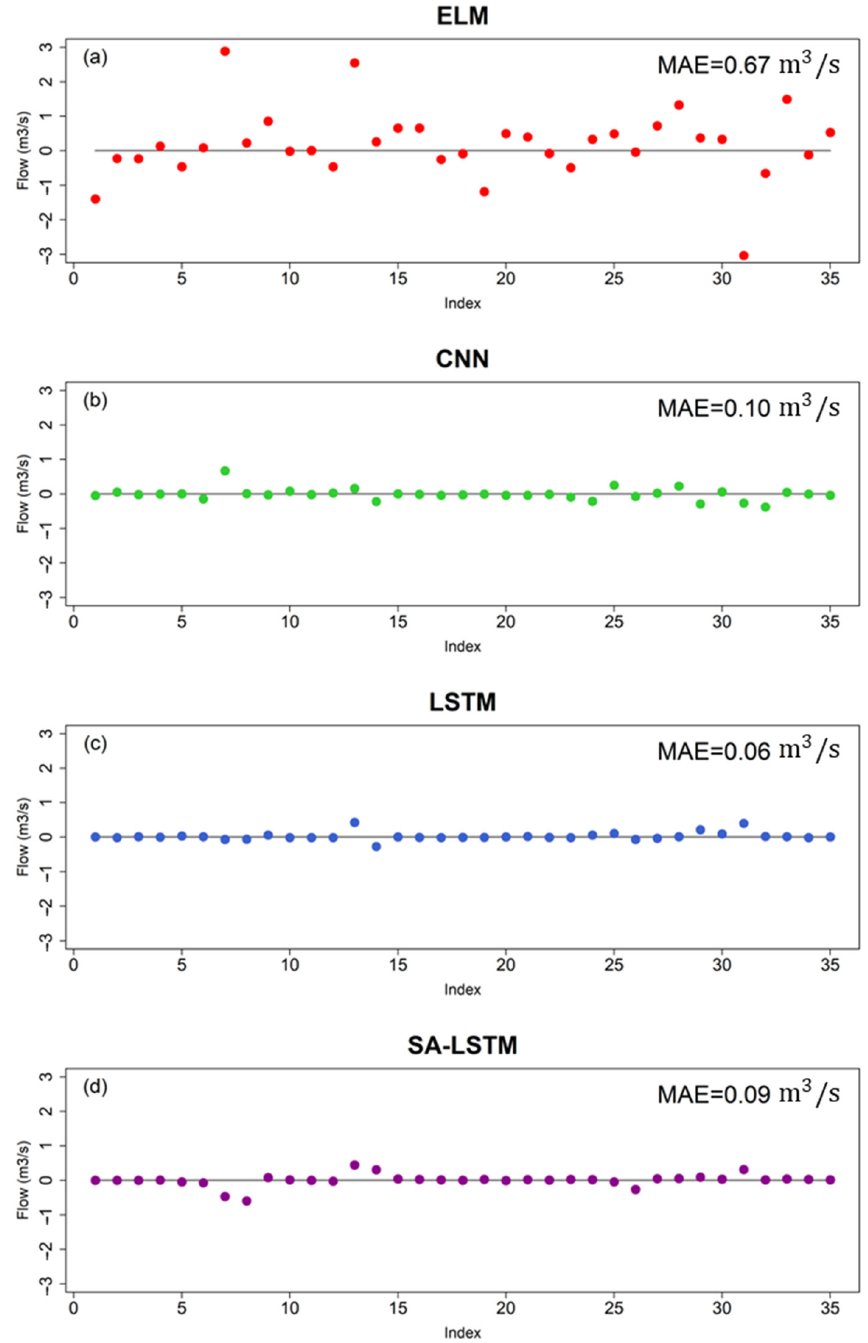
Figure 6. Observed vs. simulated flowrates for the no-flow events by the investigated models during the testing period.